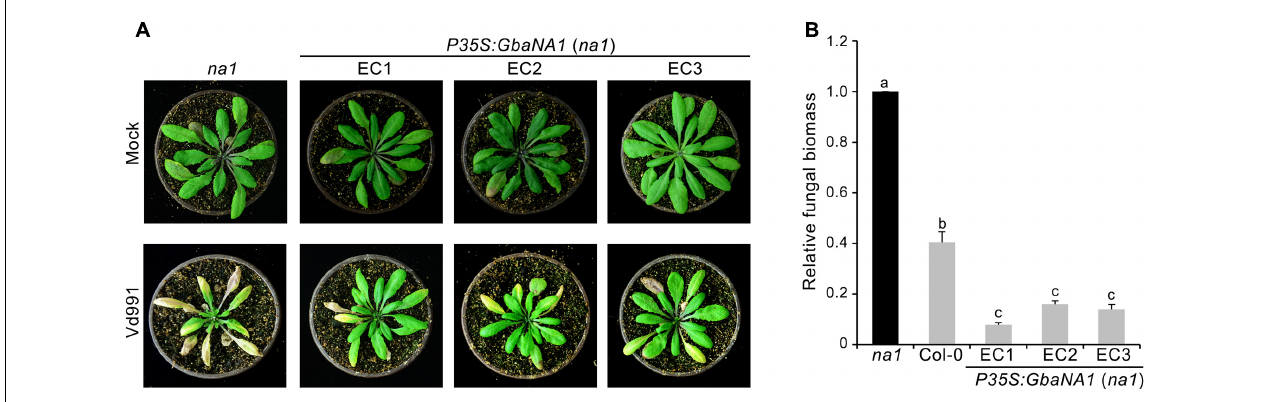
FIGURE 3 | Overexpression of cotton GbaNA1 in Arabidopsis thaliana mutant At4g27220 ( na1 ) enhances the Verticillium wilt resistance of A. thaliana . (A) Enhancement of the Verticillium wilt resistance of na1 A. thaliana mutants by GbaNA1 overexpression. Overexpression of GbaNA1 was driven by the CaMV 35S promoter. Three-week-old transgenic lines (EC1, EC2 and EC3) were subjected to a root-dip inoculation in a suspension of 5 × 10 6 conidia/mL of V. dahliae , strain Vd991. Verticillium wilt symptoms were assessed 21 d after inoculation. Sterile water root dips were used as controls (Mock). (B) Quantification of V. dahliae biomass in transgenic GbaNA1 overexpression lines of na1 mutants, na1 mutant and the wild-type (Col-0). Relative fungal biomass was determined using quantitative real-time PCR and genomic DNA extracted from total plants 21 days after inoculation. V. dahliae elongation factor 1- α ( EF-1 α ) was used to quantify fungal colonization, and A. thaliana UBQ1 was used as an endogenous plant control. Error bars represent standard errors of three biological replicates. Different letters above the bars indicate significant differences ( P < 0.01).